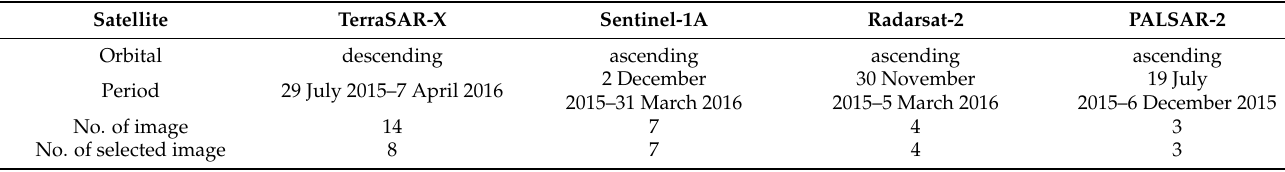
Table 1. SAR datasets used in this